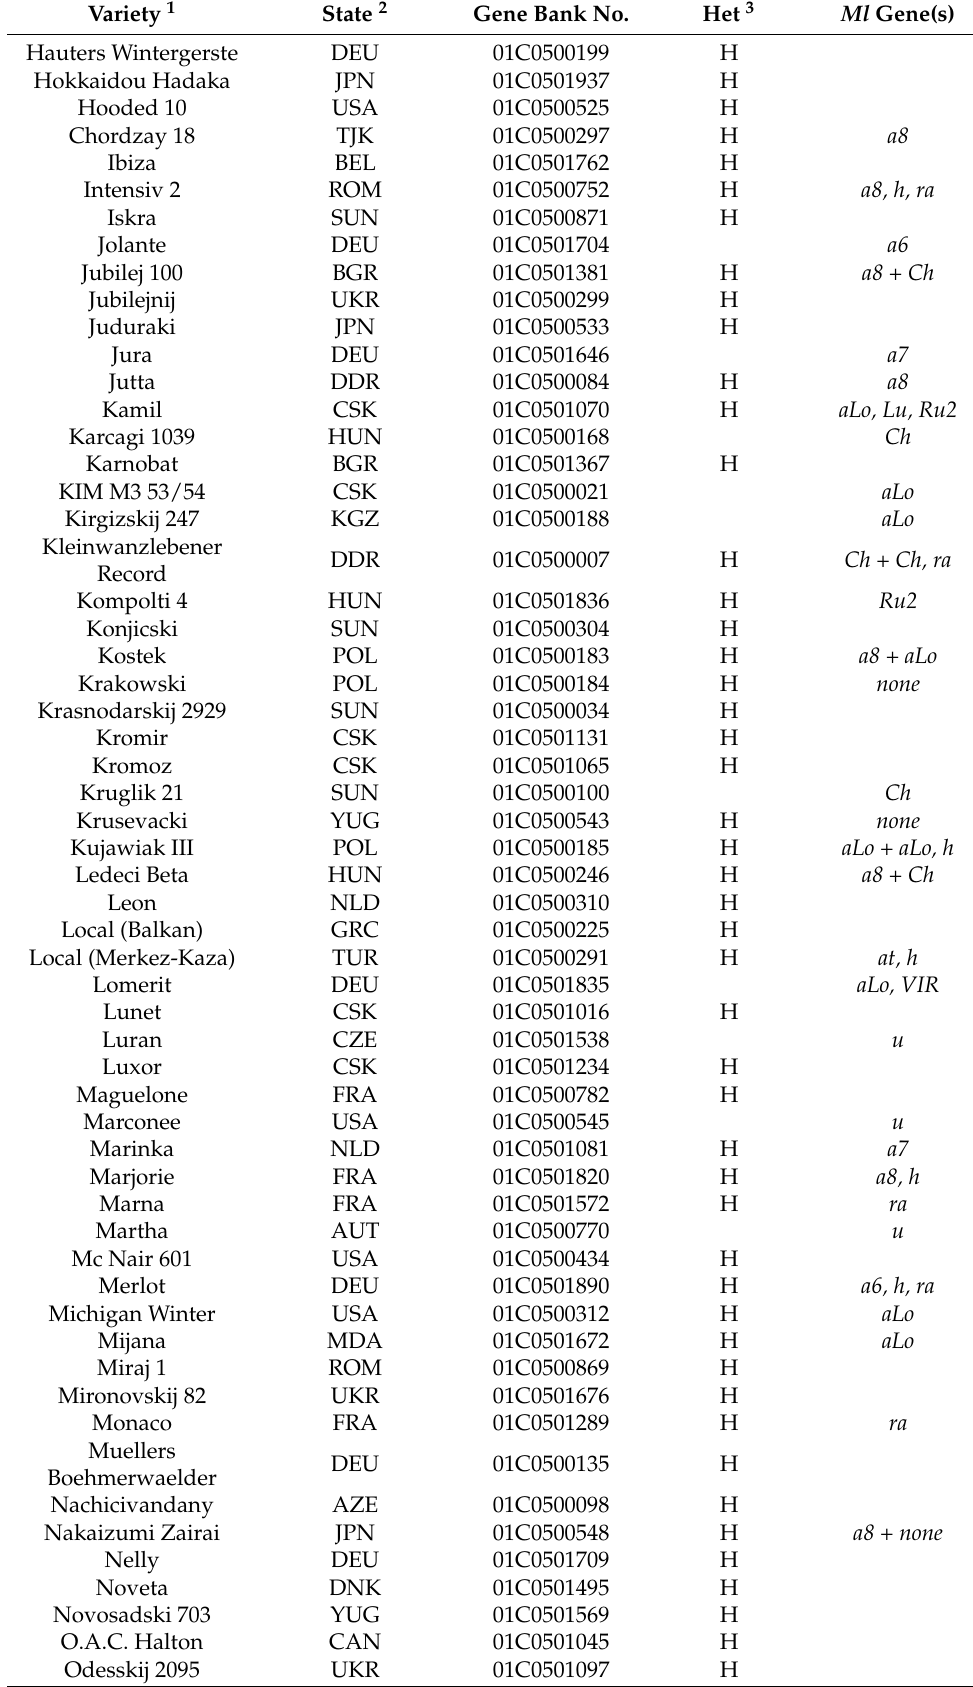
Table 2. Cont. Variety